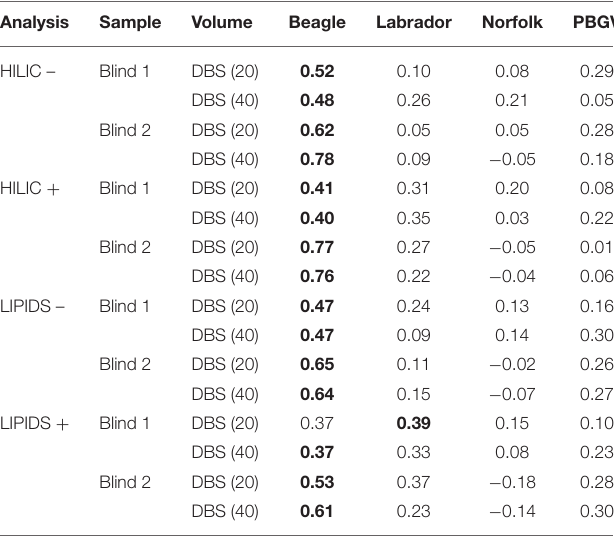
TABLE 2 | Breed prediction for the two blinded dried blood spot (DBS) samples based on PLS-DA predicted values.